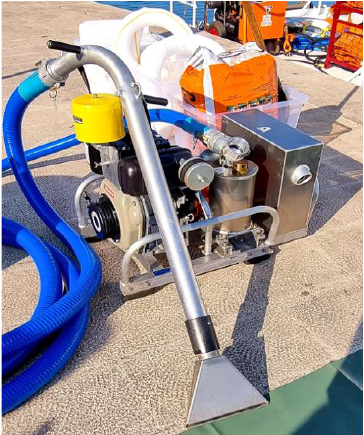
Figure 5 . Vacuum skimmer. [Authors].